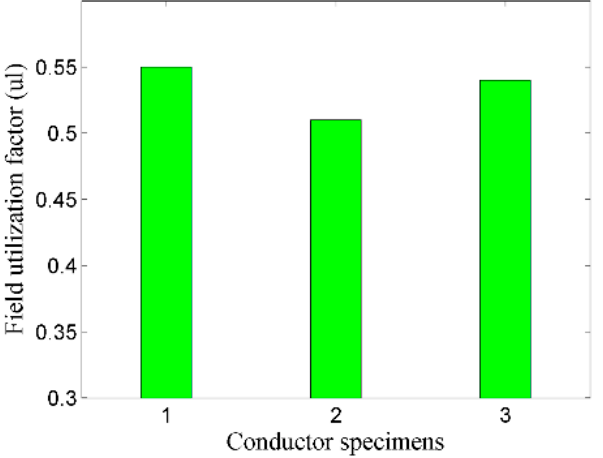
Figure 11. Average and maximum electric field comparison regarding the different conductor specimens described in Table 3.